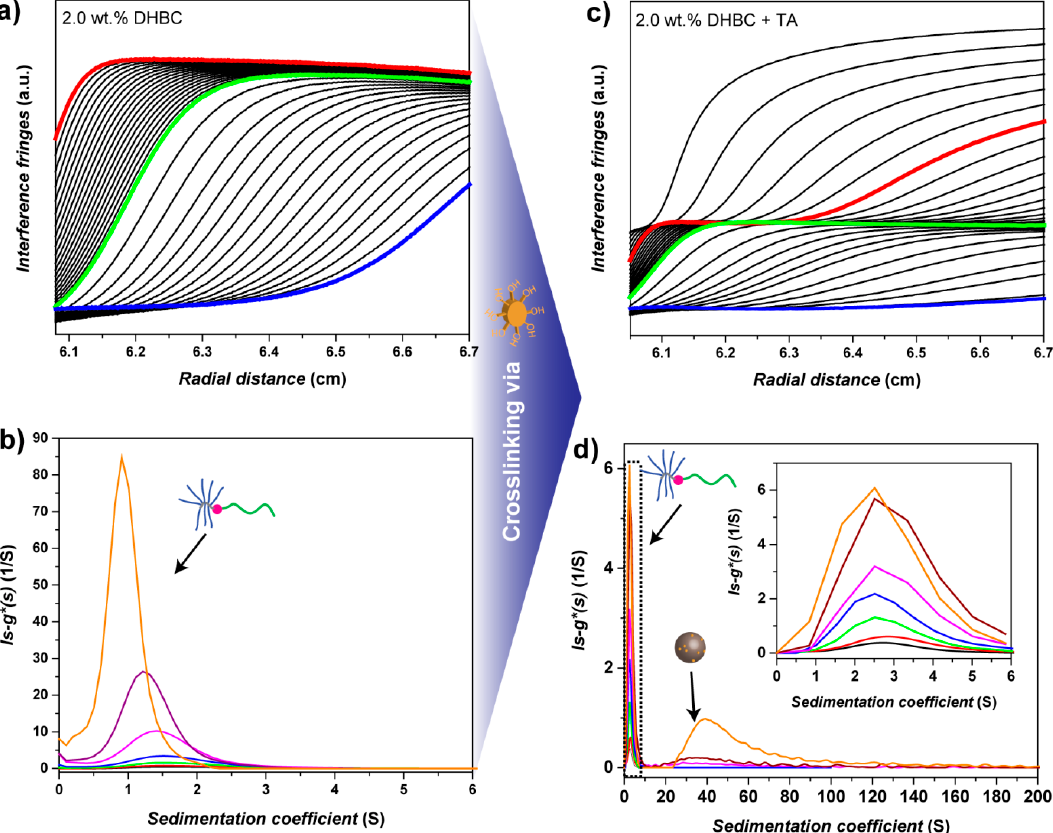
Figure 3. ( a ) Selected sedimentation velocity profiles of aqueous PVP- b -P(OEGMA) solution at 2.0 wt.% concentration with highlighted profiles more close to the beginning of the experiment (red), at an intermediate timescale (green), and close to the end (blue). ( b ) Sedimentation coefficient distribution, ls-g*(s), of PVP- b -P(OEGMA) with varying concentrations (0.03 wt.% (black), 0.05 wt.% (red), 0.1 wt.% (green), 0.2 wt.% (blue), 0.5 wt.% (magenta), 1.0 wt.% (brown), 2.0 wt.% (orange)). ( c ) Sedimentation velocity profiles of aqueous PVP- b -P(OEGMA) solution after the non-covalent crosslinking with TA was performed at 2.0 wt.% polymer concentration with highlighted profiles as in ( a ). ( d ) Sedimentation coefficient distribution, ls-g*(s) of PVP- b -P(OEGMA) after the non-covalent crosslinking reaction with various dilutions (0.03 wt.% (black), 0.05 wt.% (red), 0.1 wt.% (green), 0.2 wt.% (blue), 0.5 wt.% (magenta), 1.0 wt.% (brown), 2.0 wt.% (orange)), inset: magnification for the range of low sedimentation coefficients.